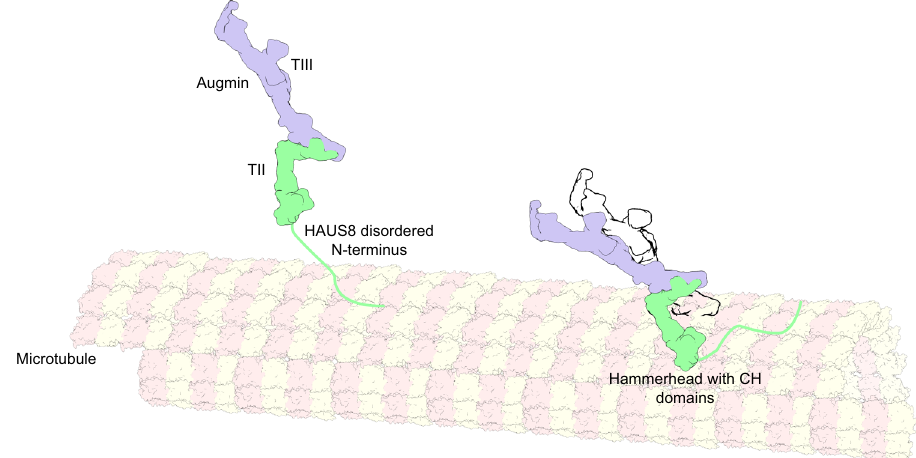
Fig. 6 | Structure-guided hypothetical model for augmin recruitment to the microtubule. Left, the augmin holocomplex is recruited to the pre-existing microtubule via the positively charged and fl exible HAUS8 N-terminus, which is essential for microtubule binding 23,30 . Right, the augmin holocomplex is stabilised and oriented on the microtubule lattice via HAUS6/HAUS7 CH domain binding, as